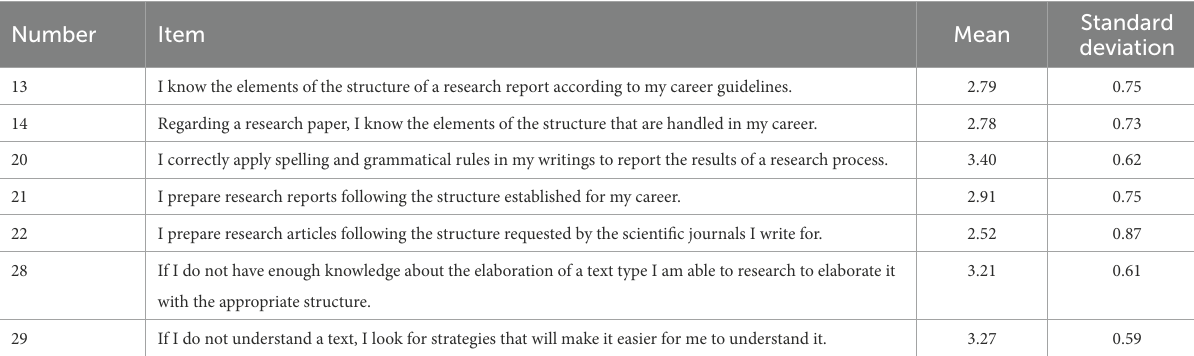
Learning by being